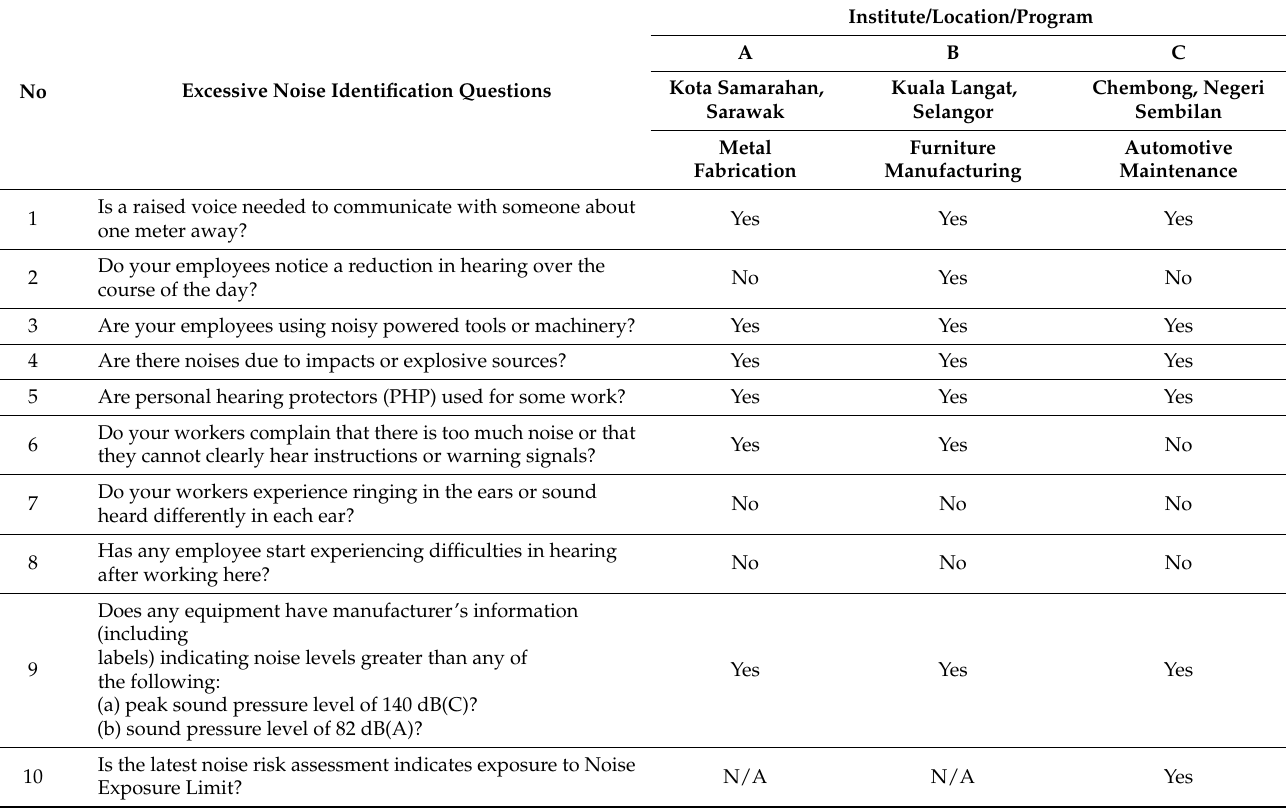
Table 1. Results of noise hazard identification.